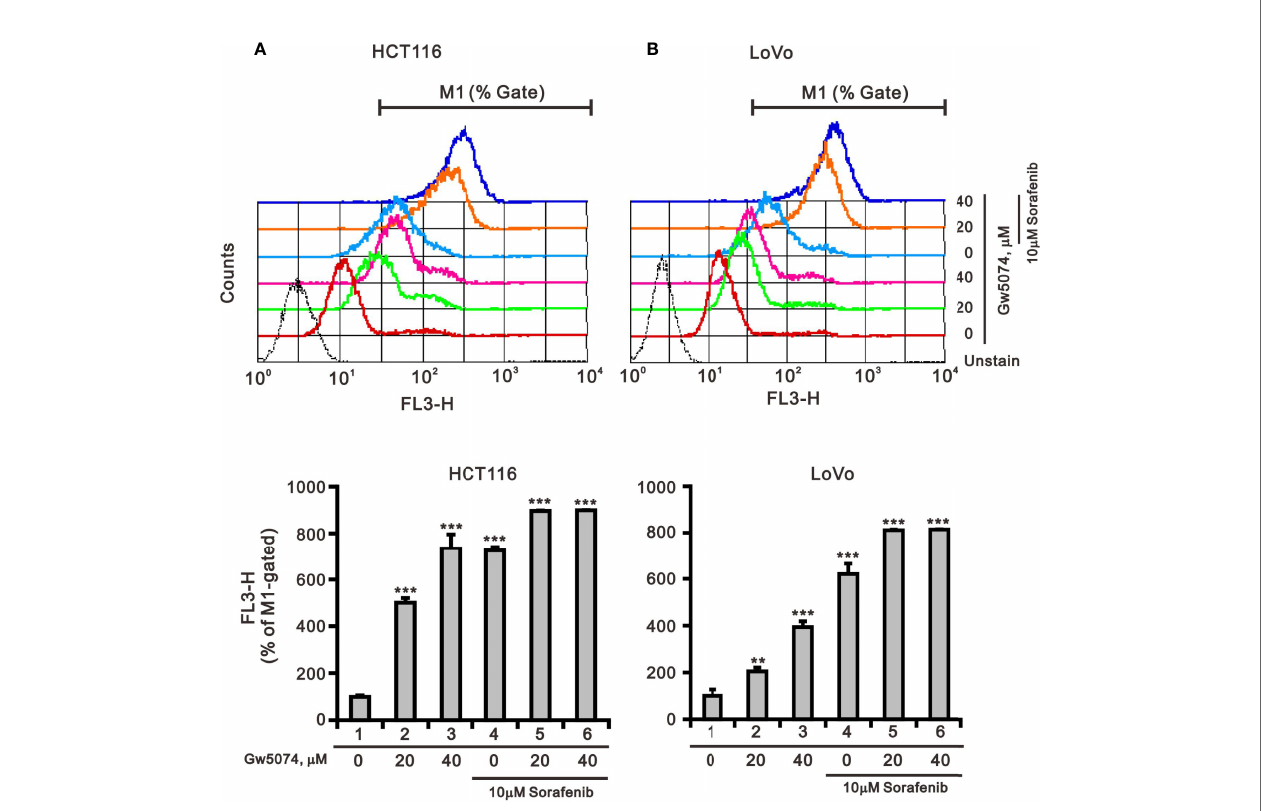
FIGURE 8 | The effects of GW5074 and sorafenib on the mitochondrial ROS generation of HCT116 and LoVo cells. HCT116 (A) and LoVo (B) cells were treated with 0, 20, and 40 µM GW5074 in the absence or presence of 10 µM sorafenib for 24 h, after which the live cells were stained with 5 mM MitoSOX ™ Red for 10 min at 37°C and assayed using a fl ow cytometer. The results are representative of three independent experiments. **p < 0.01 and ***p <